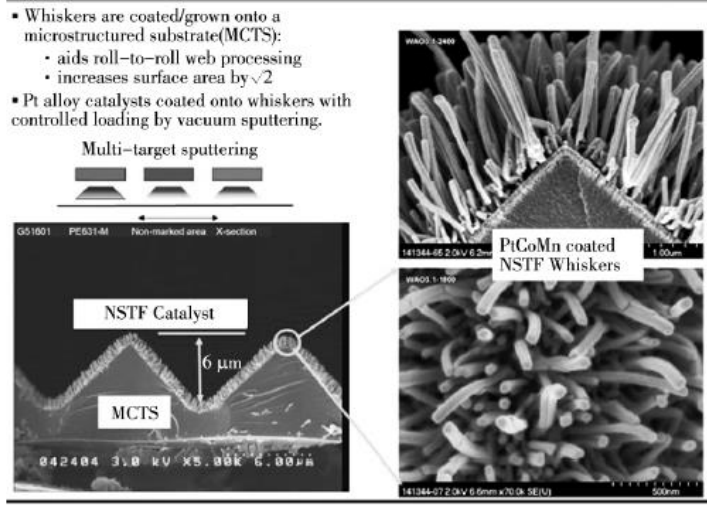
Figure 7. Schematic diagram of ordering the MEA by 3M [61].